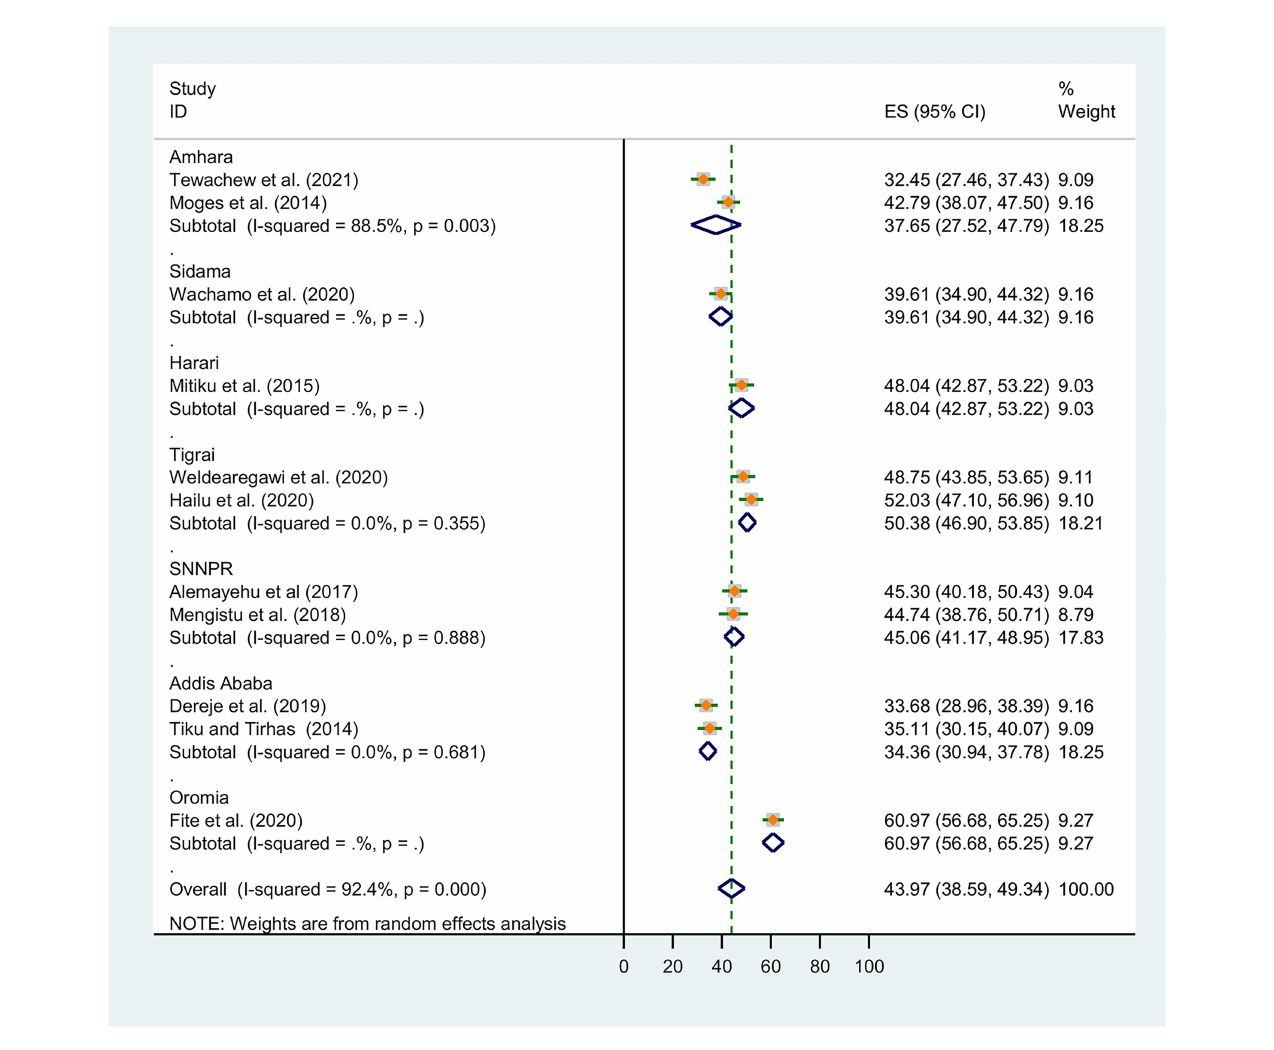
FIGURE 3 Subgroup analysis for the pooled prevalence of OIs by Ethiopia’s